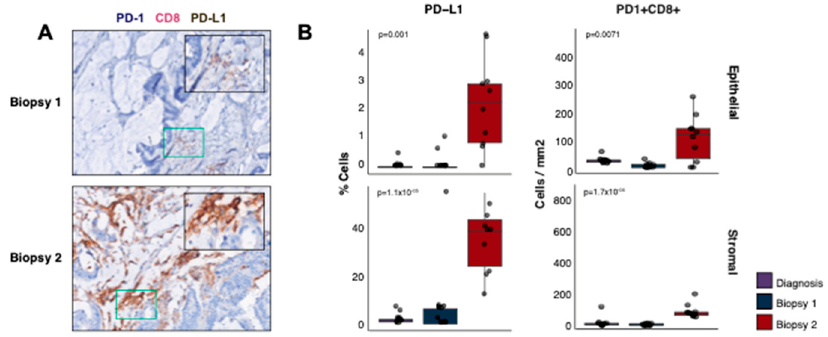
Figure 5. Immune exhaustion and resistance. ( A ) m-IHC staining for PD-1, CD8 and PD-L1 in biop- sies one (top) and two (bottom). The colour stain for each protein is indicated in the label above the images. ( B ) The percentage of cells expressing PD-L1 (top row) and IHC cell counts/mm 2 for PD-1+ CD8+ cells (bottom row) in biopsies one, two and the diagnostic sample. The cell counts are split into epithelial (left) and stromal (right) compartments. The p -values displayed are two-tailed Wilcoxon rank sum tests between the first and second biopsies.